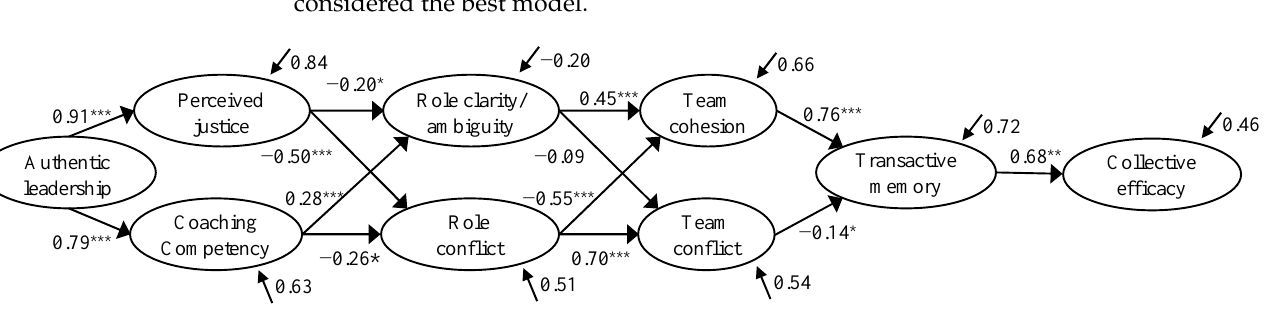
considered the best model.